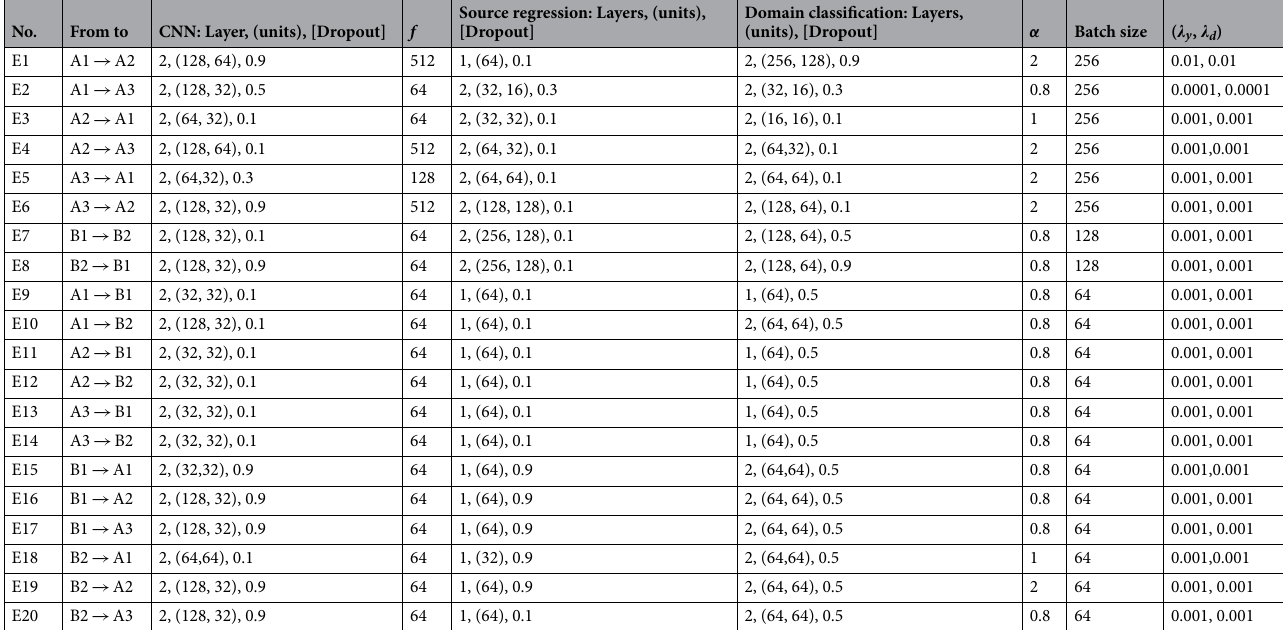
Table 4. Selected hyperparemeter for each source-target experiment